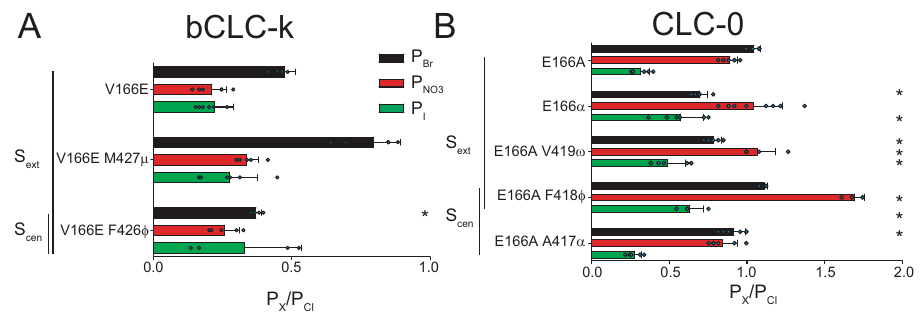
Fig. 4 | A glutamate side chain at the Glu ex position modulates the role of S cen and S ext in anion selectivity. A , B Effect of replacing backbone amides with ester oxygens lining the S ext and S cen sites in V166E bCLC-k ( A ) and E166A CLC-0 ( B ) on P Br (blackbars),P NO3 (redbars)and PI (greenbars).DataareMean±St.Dev.of n >4 repeatsfrom N ≥ 3independentoocytebatches,individualdatapointsareshownas cyan circles. The statistical signi fi cance of the effects of the mutants on the